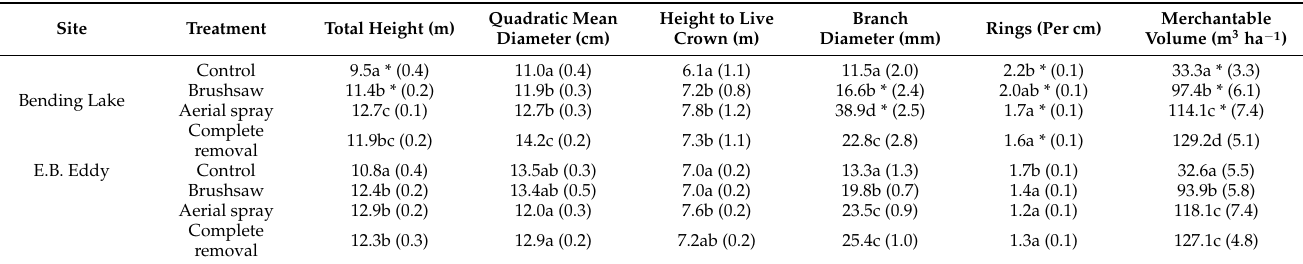
Table 5. Estimated marginal means ( ± SE) for individual jack pine growth characteristics ( n = 360), grouped by site x treatment variables after vegetation management applied on two sites (Bending Lake and E.B. Eddy) in Ontario, Canada. Different lowercase letters indicate statistically significant differences from Tukey’s honest significant difference (HSD) test (pairwise comparisons between each treatment and control) within each site. Asterisk (*) indicates statistically significant differences from pairwise comparisons between